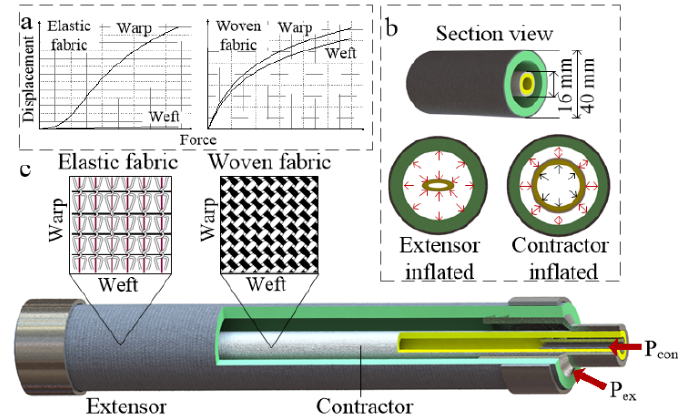
Figure 1. A conceptual representation of the soft actuator. ( a ) Force-deformation test of fabrics in warp and weft direction. ( b ) Section view of the actuator and state of extensor and contractor bladders in inflation. ( c ) Overall structure of actuator.